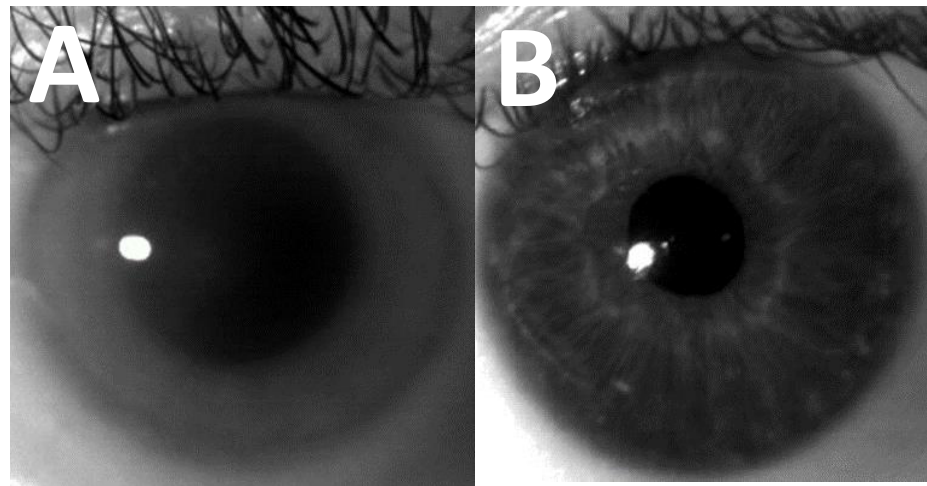
Figure 1. ( A ) Corneal image of a patient with MPS I Hurler demonstrating significant corneal clouding. ( B ) Corneal image of a patient without corneal clouding. Images were taken using IrisGuard AD100, MREH.